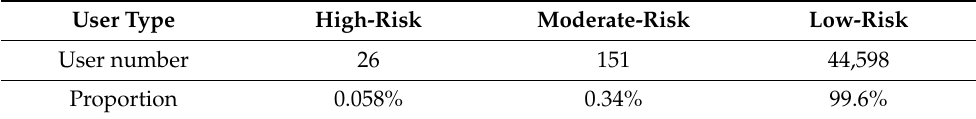
Table 4. Classification of high-risk groups.